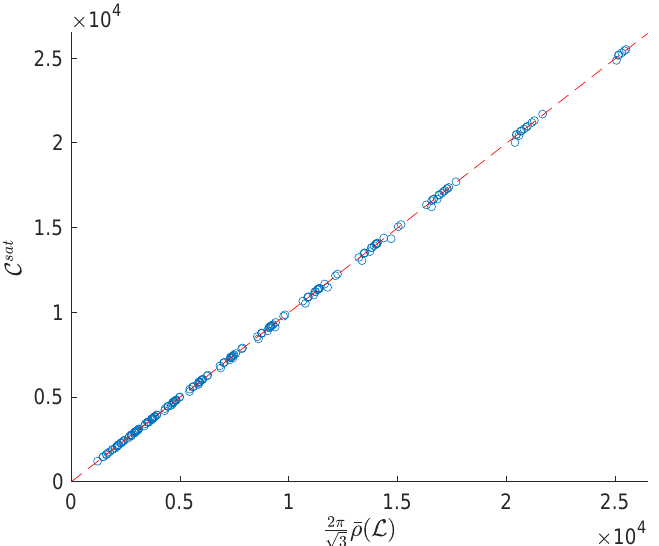
Figure 10: Numerically computed complexity saturation values for instances of the chaotic and truncated Szeg˝o Hamiltonians with N = M = 25,...,35 and k = 4,6,8 plotted against the estimate (3.23). The red line is a linear fit to the data points with slope ∼